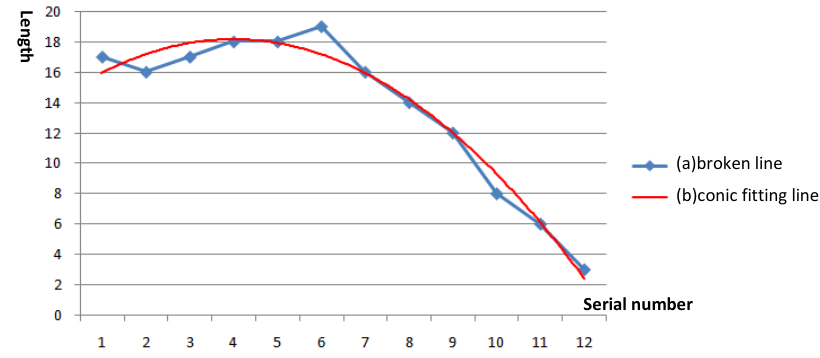
Figure 9. Graphical representation of the diagonal lines’ lengths of the U-shaped curve: ( a ) broken line; and ( b ) conic fitting line.